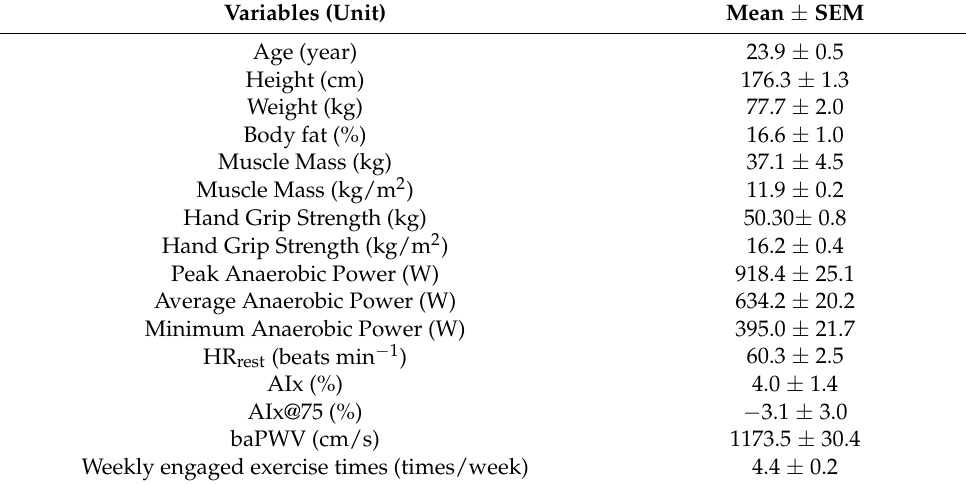
Table 1. Basic clinical characteristics of